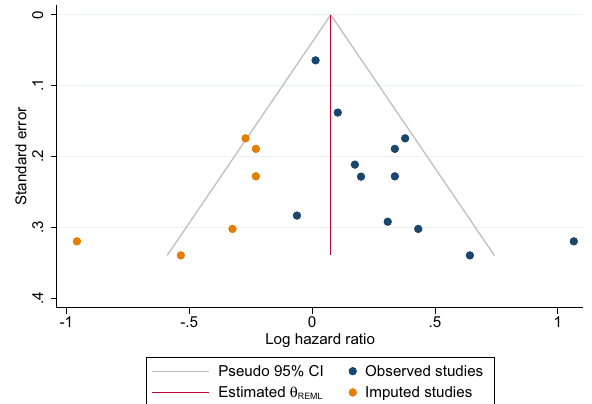
Fig. 5 Funnel plot assessing the presence of publication bias in the overall survival analyses. * The Duval and Tweedie trim-and- fi ll method 30 was used to adjust for publication